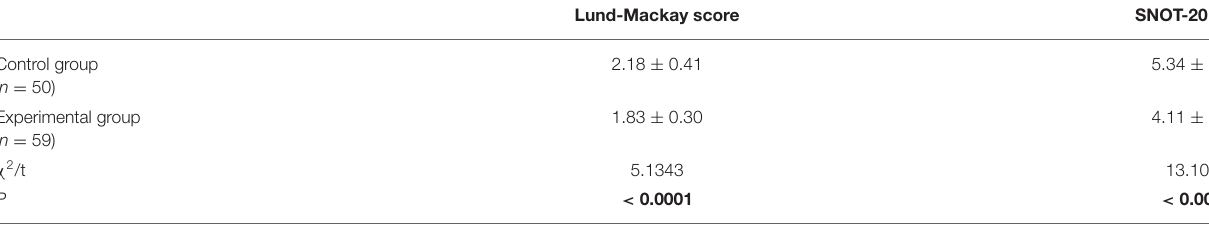
TABLE 6 | Comparison of nasal mucosal recovery of patients between the two groups.